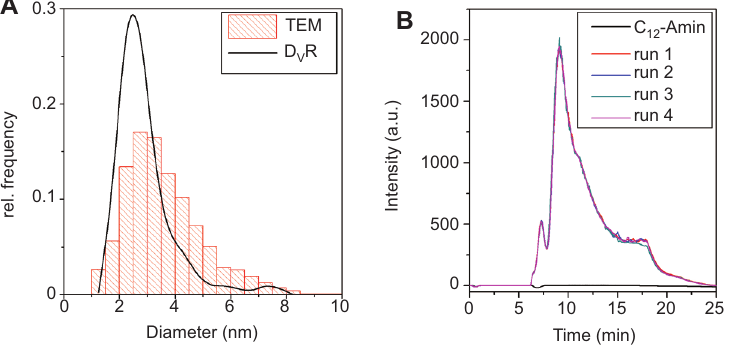
Figure 2 Comparison of the volume-weighted particle size distribution of the initial sample determined by the TEM and SAXS data evaluation (A) and the AF4 fractograms of the initial sample and C